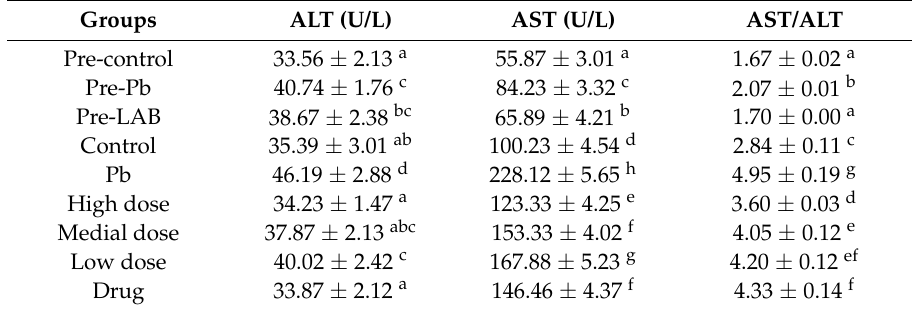
Table 6. Effects of L. bulgaricus KLDS1.0207 on Pb-induced variations in the activity of marker enzymes in the serum of mice.